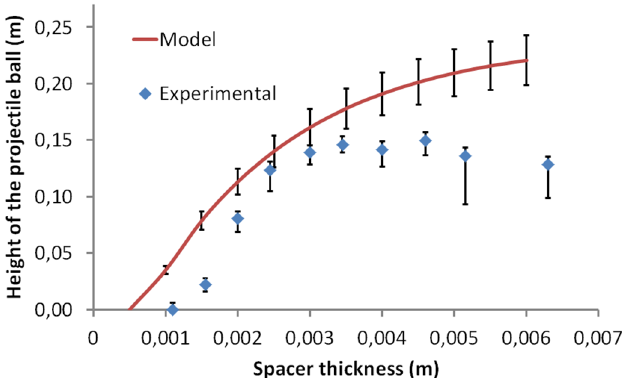
Fig. 13. Experimental and simulated results for the final height reached by the projectile ball as a function of the thickness of the